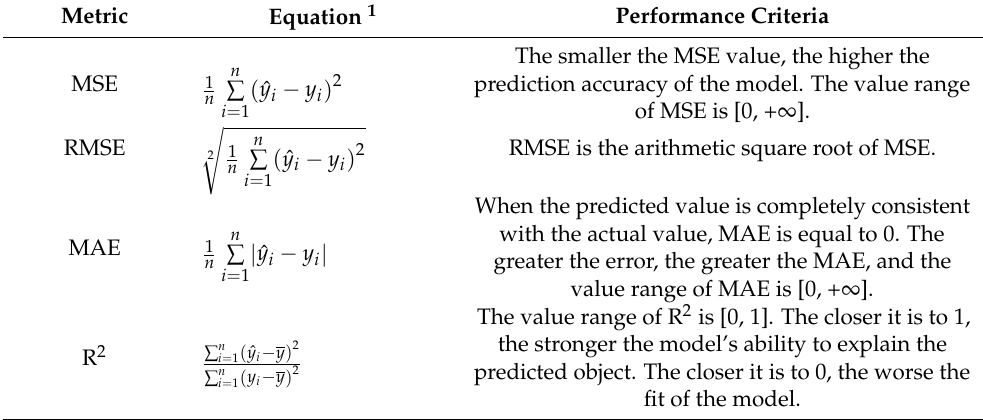
Table 5. Evaluation metrics of the